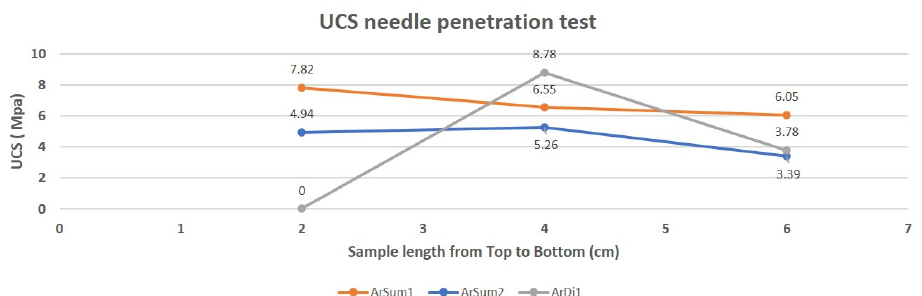
Figure 8. UCS estimated by needle penetration test of Diolkos artificial beachrock sample ArDi1 (grey line) and Okinawa artificial beachrock sample ArSum1 (orange line) and ArSum2 (blue line) in consideration of samples length from the top part (0 cm) to the bottom part (7 cm).